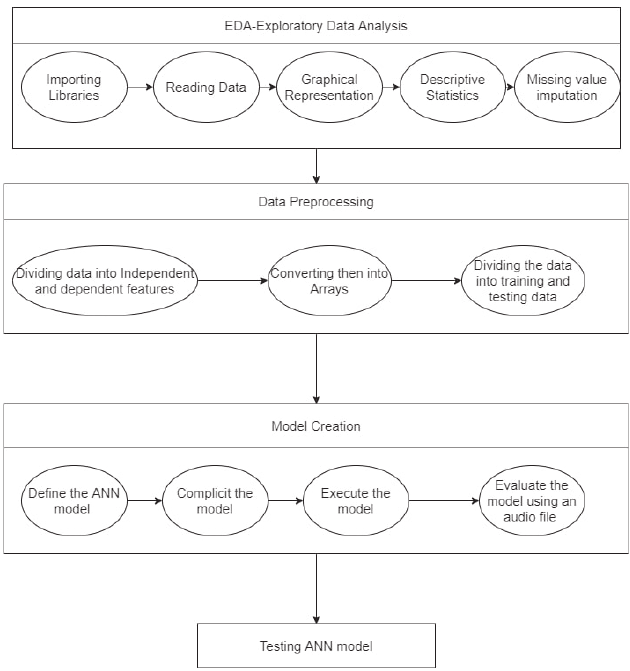
Figure 6: Model workflow on how the project is created